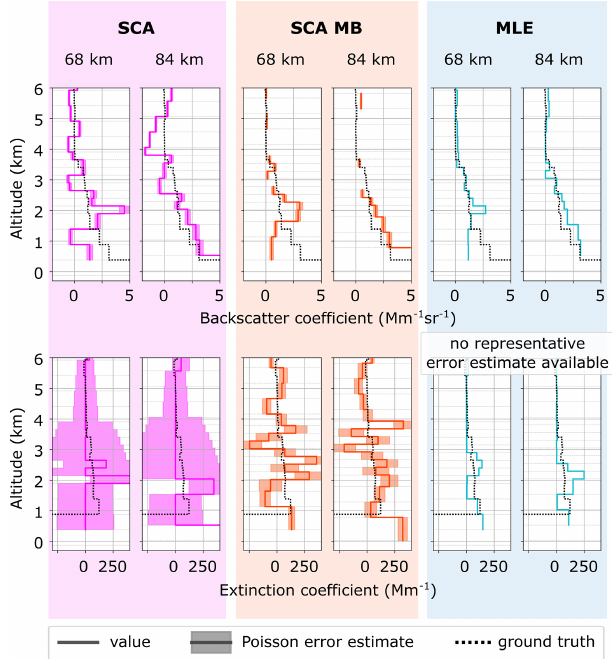
Figure 8. Real data case II: optical properties of two co-located Aeolus observations (solid coloured lines) compared to the ground truth observations over Tel Aviv (solid black lines). The ground truth co-polarized backscatter and extinction have been binned to Aeolus resolution. Applied algorithms (from left to right) are the SCA, SCA midbin and MLE. Distances between the ground station and the centre of Aeolus observation are 68 and 84km. The error bounds from Poisson assumptions are displayed in shaded